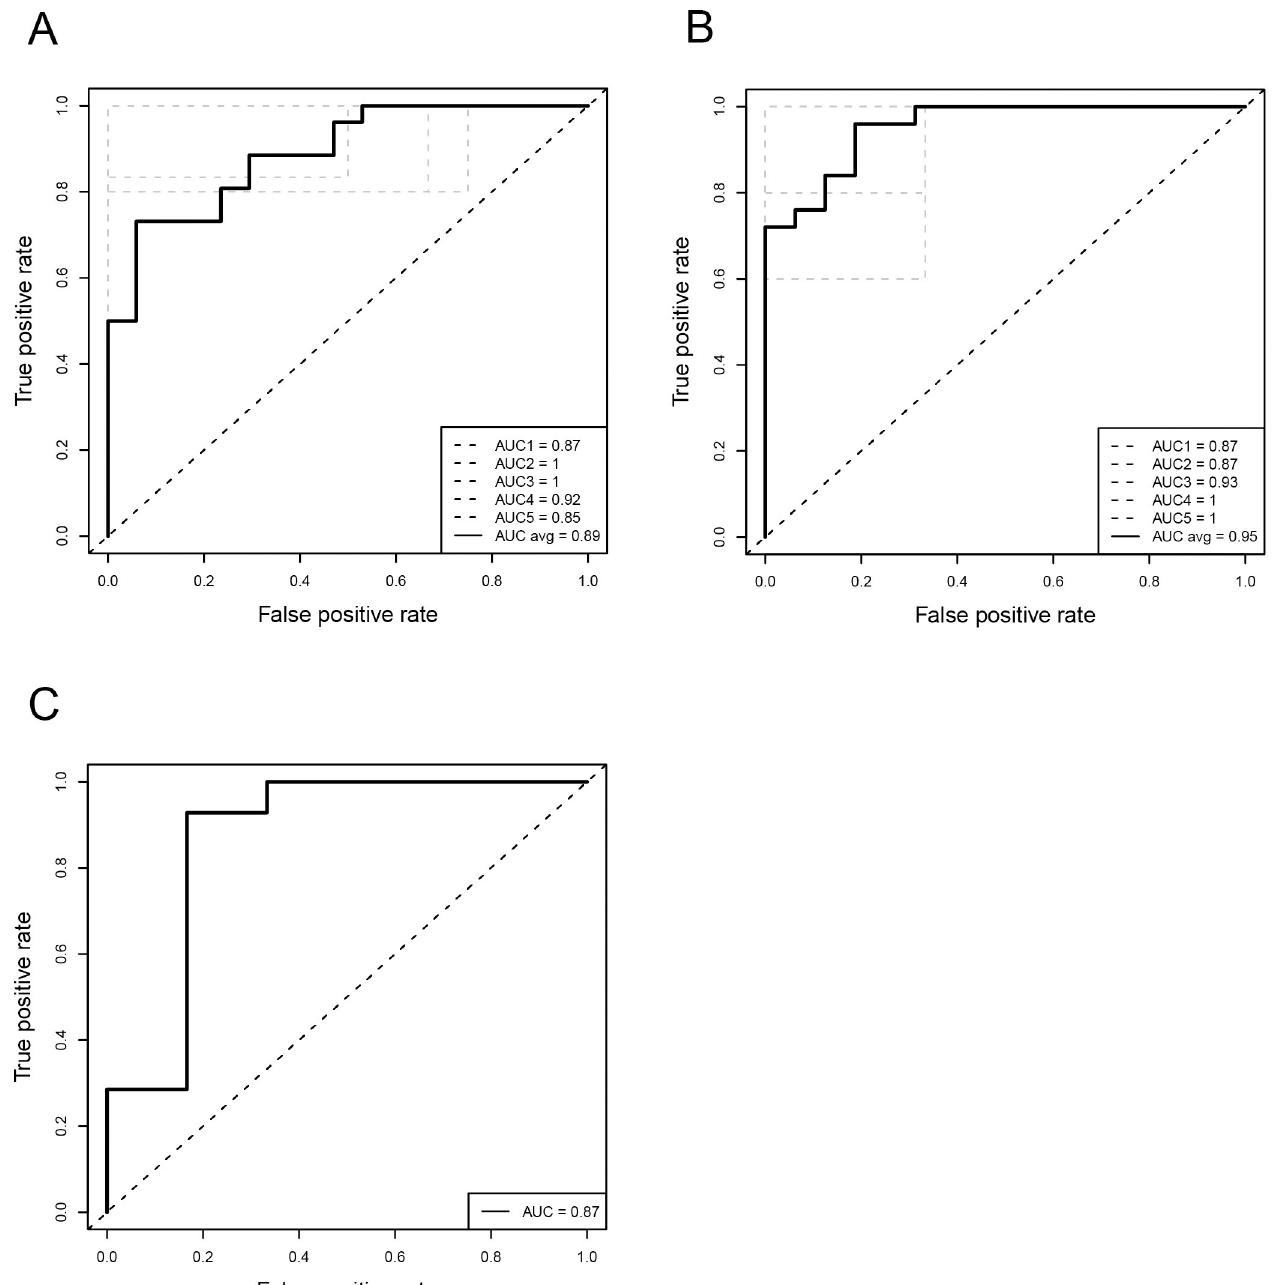
Fig 1. ROC curves for each cross validation fold (dashed-black line) and the mean ROC curve (solid black line) for random forest models fitted (A) to 43 samples and (B) to 41 samples where two samples, HD_00J and I047_005 were removed (the dashed diagonal line represent AUC = 0.5, i.e. classification at random). (C) ROC curve for independent validation test (AUC = 0.87) (n =